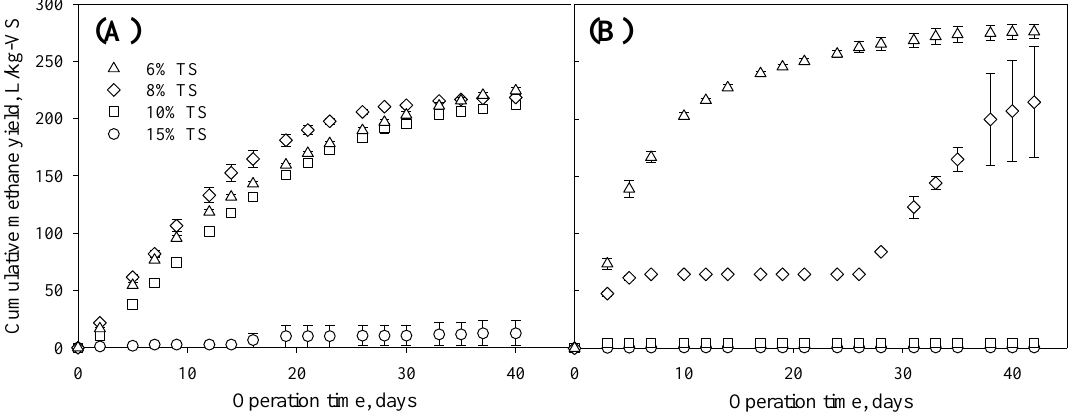
Figure 3. Methane yields of non-ensiled ( A ) and ensiled ( B ) cereal rye biomass. Table 2. Final characteristics of the digesters. (Average ±